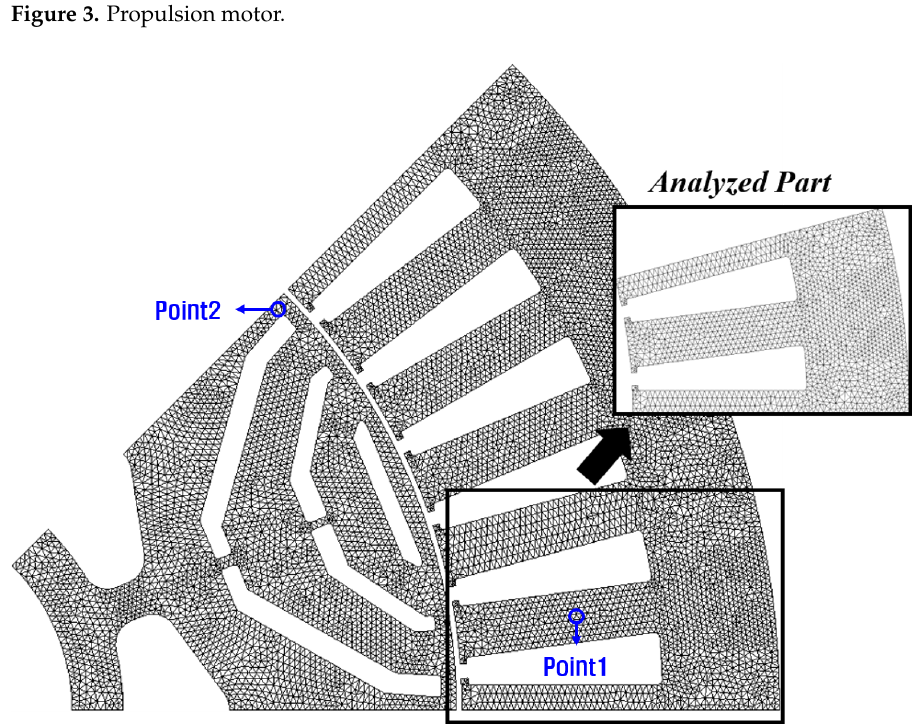
Figure 4. Mesh for the